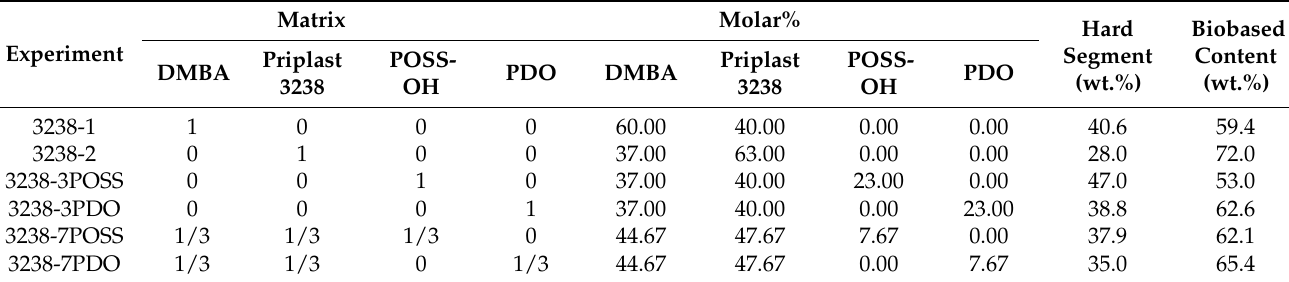
Table 1. The simplex design table with experiments carried out in this work.